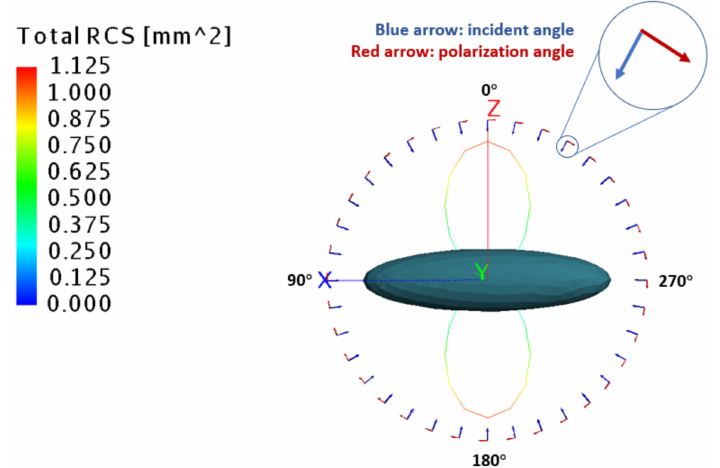
Figure 2. Simulation modeling and results for an individual insect.